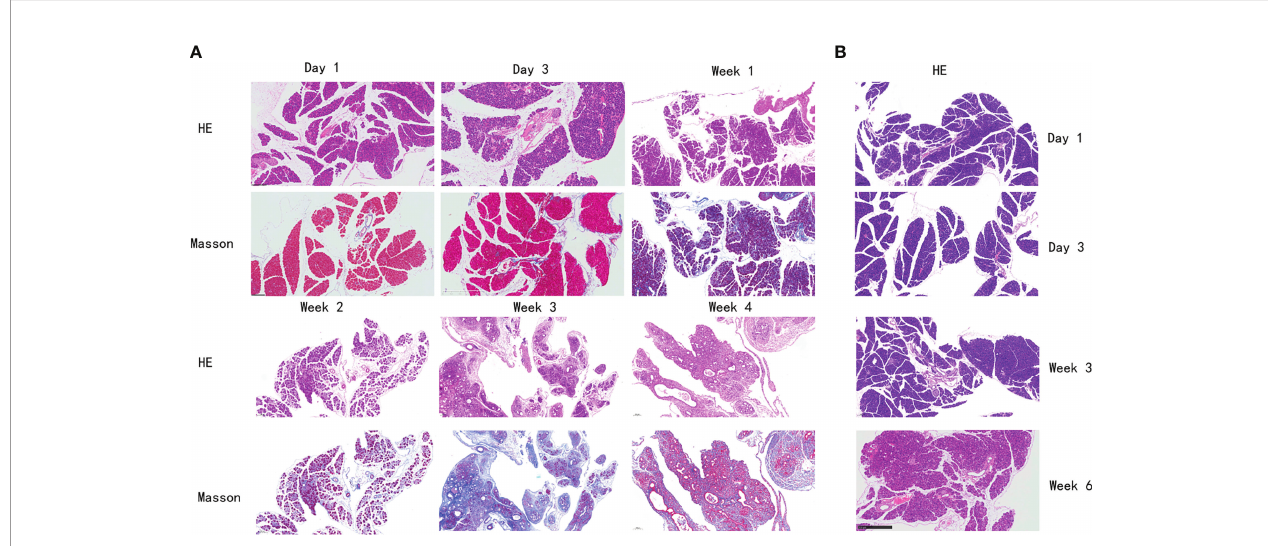
FIGURE 2 | Histological changes of the pancreas in mice with chronic pancreatitis. (A) Histological changes of mice in PG pancreas at different time points by H&E and Masson staining. (B) Histological changes of mice in VG pancreas at different time points by H&E staining. PG, retrograde pancreatic duct injection group; VG, tail vein injection group.